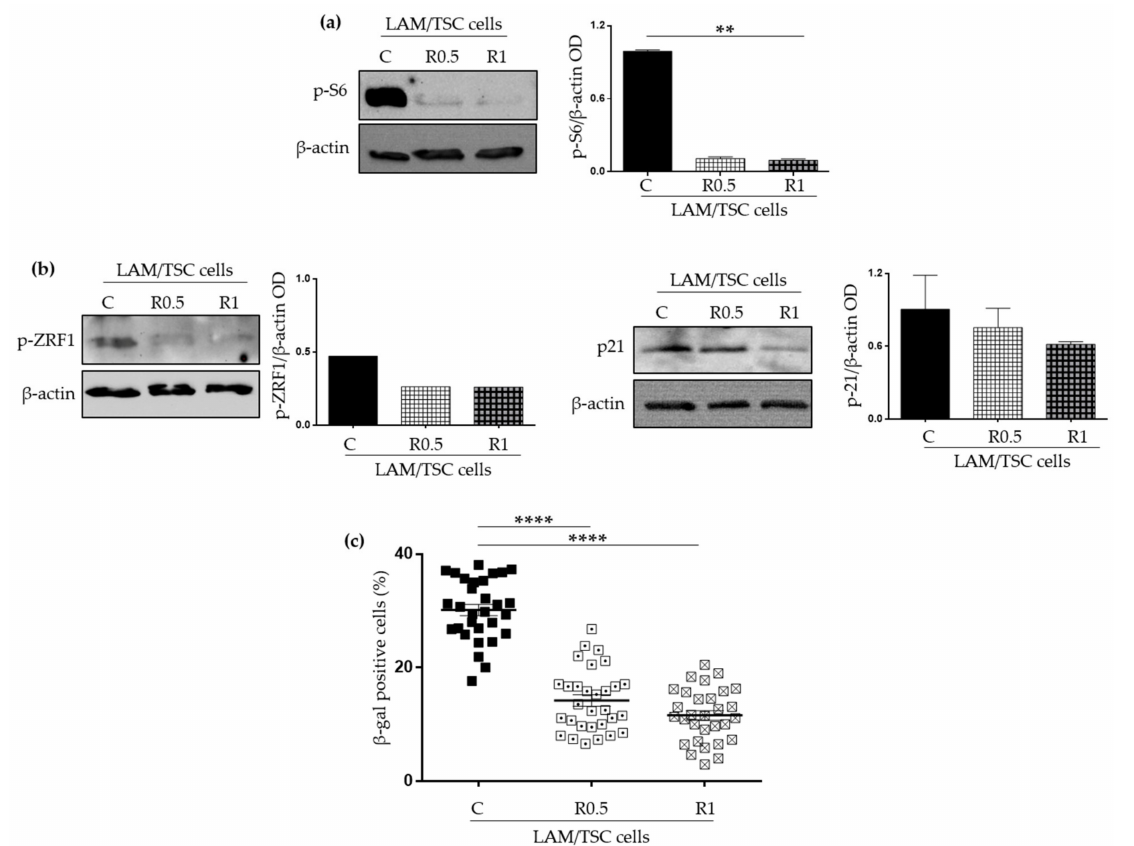
Figure 3. Analysis of the senescent characteristics of LAM/TSC cells following mTOR inhibition by rapamycin. ( a ) Phospho-S6 (p-S6) levels were evaluated in LAM/TSC cells (C) and LAM/TSC cells treated for 48 h with 0.5 ng/mL (R0.5) or 1 ng/mL (R1) of rapamycin. β -actin was used as loading control. Densitometric analysis of p-S6/ β -actin is shown. Results are shown as mean ± SEM ( n = 3). ANOVA with Tukey Test, ** p < 0.01 ( b ) Senescent markers p21 WAF1/CIP1 (p21) and phospho-ZRF1 (p-ZRF1) were analysed by Western Blot analysis in LAM/TSC cells (C) and in LAM/TSC cells treated for 48 h with 0.5 ng/mL (R0.5) or 1 ng/mL (R1) of rapamycin. β -actin was used as loading control. Densitometric analysis of p-ZRF1/ β -actin and p21/ β -actin are shown. Results are shown as mean ± SEM ( n = 3). ANOVA with Tukey, ns ( c ) Quantification of SA- β galactosidase positive LAM/TSC cells was performed in standard condition (C) or after the treatment with 0.5 ng/mL (R0.5) or 1 ng/mL (R1) of rapamycin for 48 h on 3 independent experiments evaluating 10 images each experiment. Results are shown as mean ± SEM ( n = 30). ANOVA with Tukey Test, **** p <